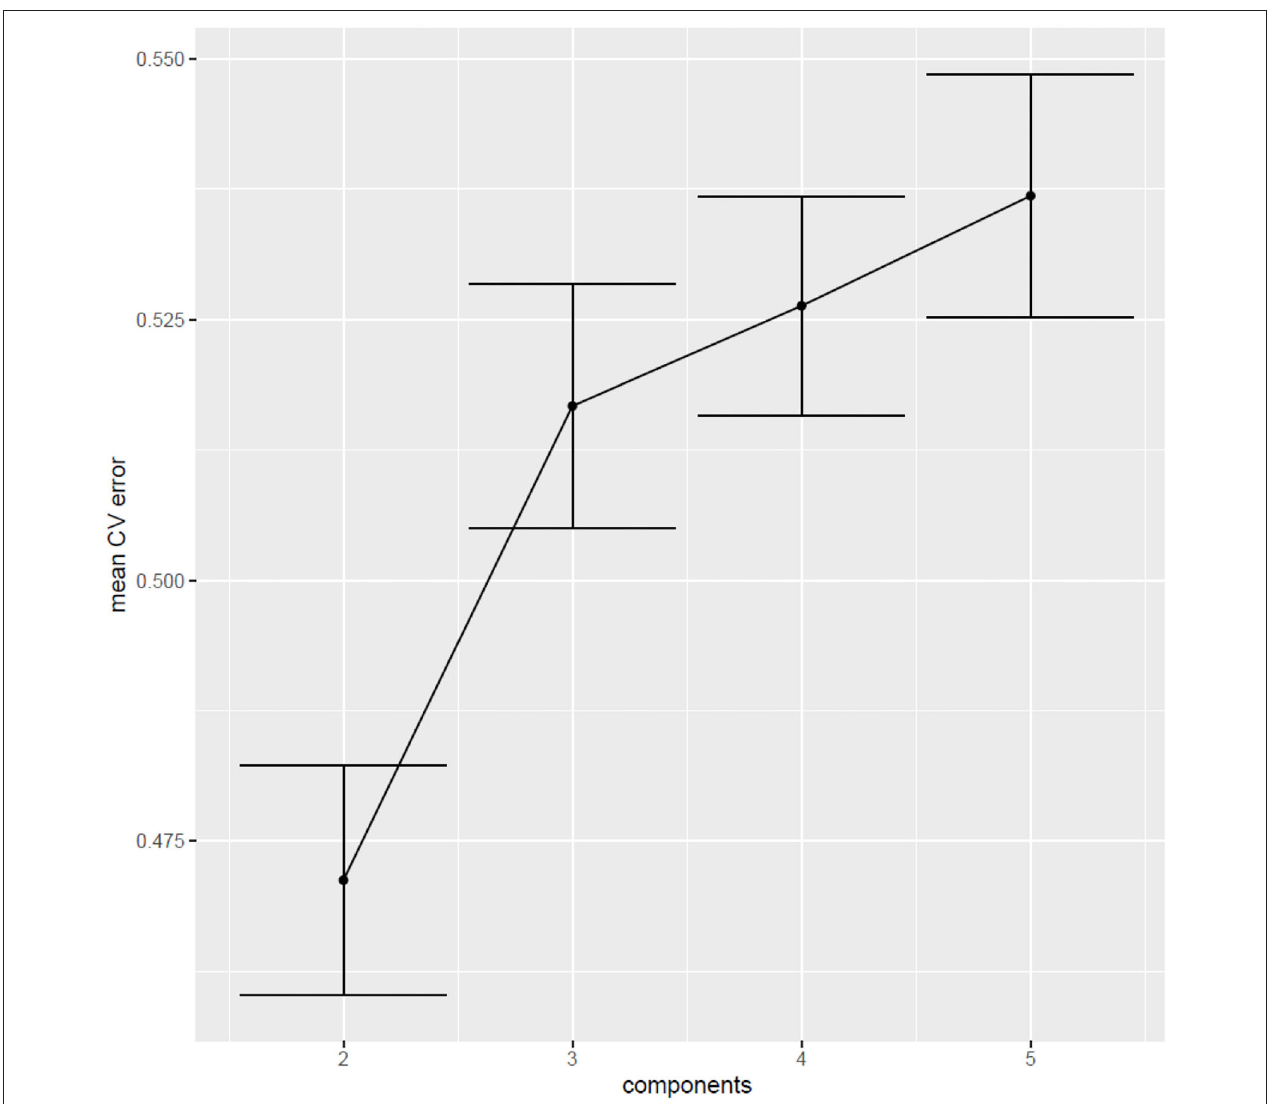
FIGURE 4 | Cross-validation error (5-fold) of 500 iterations a,b . a This figure shows the cross-validation error of the models vs. the number of components. The error bars represent the 95% confidence interval around the mean CVerror (across 500 runs of 5-fold CV). The best performance is observed in the models with 2 components, with a CVerror of 47% [95% CI (0.46; 0.48)]. b CV,